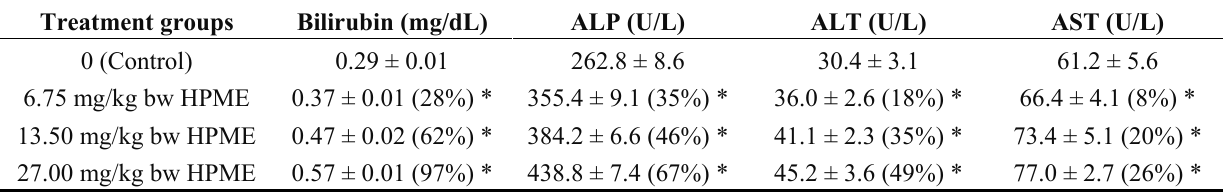
Table 2. Effect of haloxyfop- p methyl ester on plasma biomarkers of hepatic function in rat. Treatment